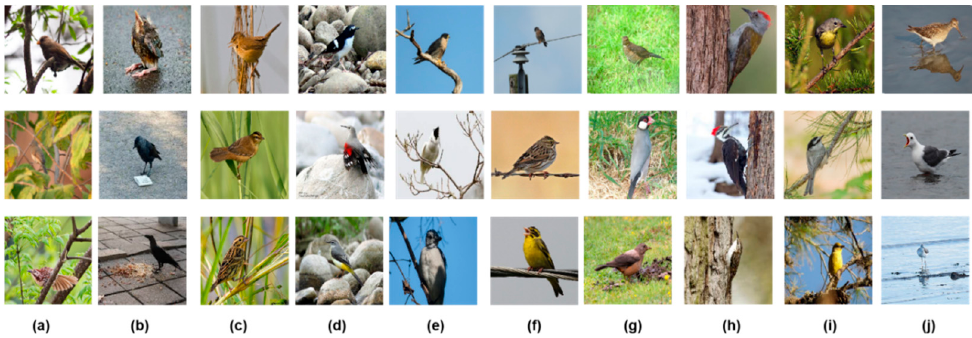
Figure 1. Sample images from our proposed database, HEOBs-10. Ten habitat elements are included. The three images in each column belong to the same category, and the letters a to j refer to broad leaves, hard ground, stalk, stone, leafless, wire, grassland, trunk, coniferous tree, and water, respectively.